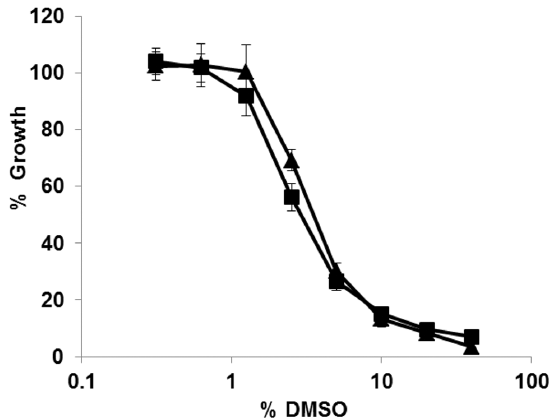
Figure 4. The effect of DMSO on growth of M.tuberculosis . M. tuberculosis growth was monitored in 96-well plates. DMSO was added as serial dilutions at a starting concentration of 40%. After 5 d of incubation at 37 u C % growth was calculated by dividing RFU (triangles) or OD 590 (squares) by the average of 4 control culture wells containing no DMSO. Results are the average of 8 independent dose response curves; error bars represent standard deviation.